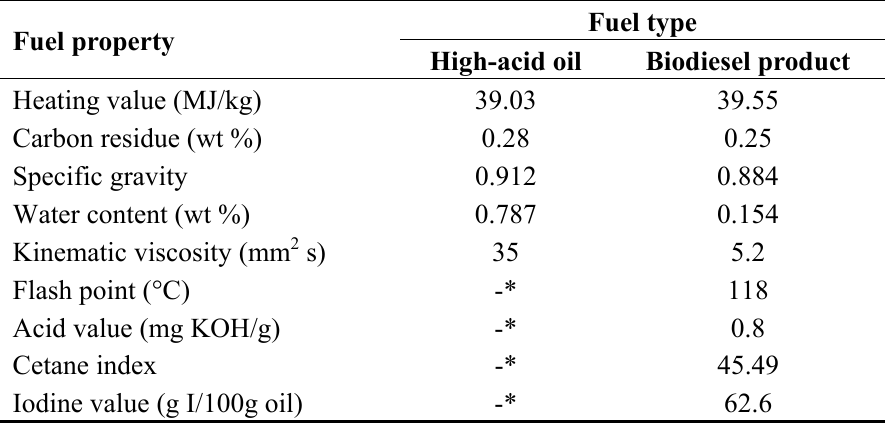
Table 1. Fuel properties of the high-acid oil and its biodiesel product with a molar ratio of methanol to high-acid oil of